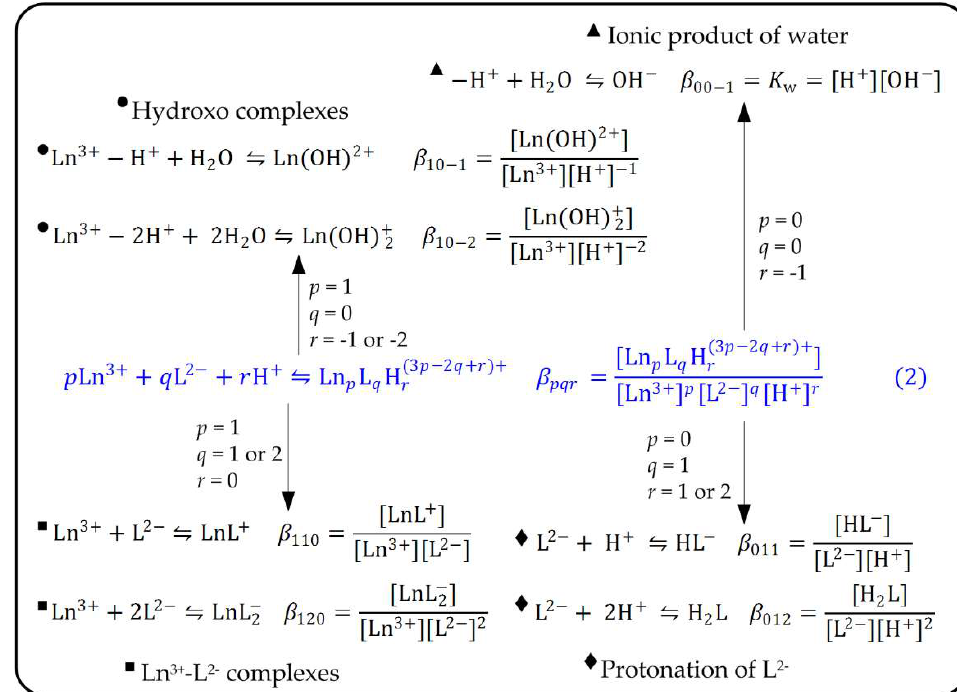
Figure 4. Examples of instances of the general Equation (2) employed to generate a speciation model to be evaluated by the Hyperquad program and significance of the β pqr formation constants in the output of the program.